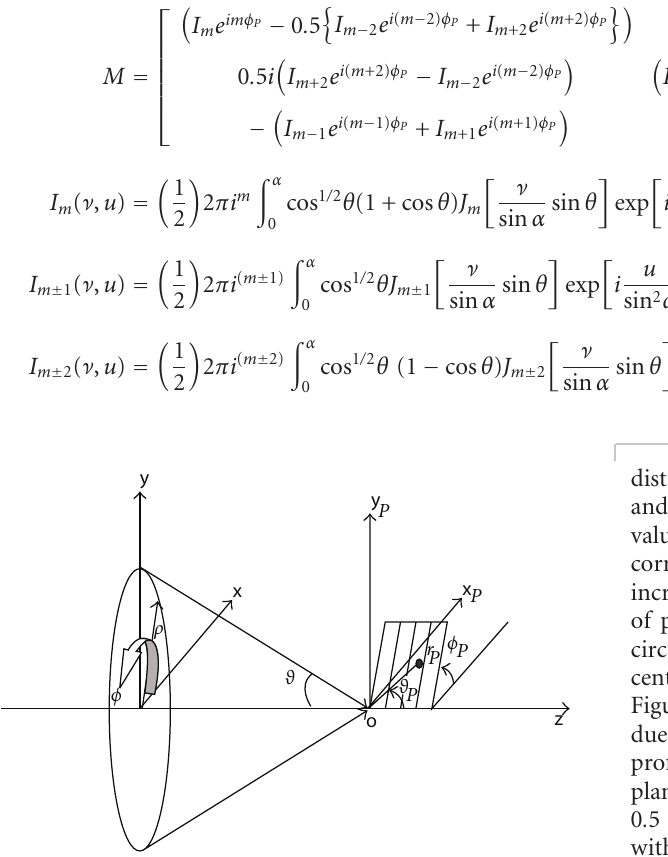
Figure 1: Focusing geometry of optical beams.